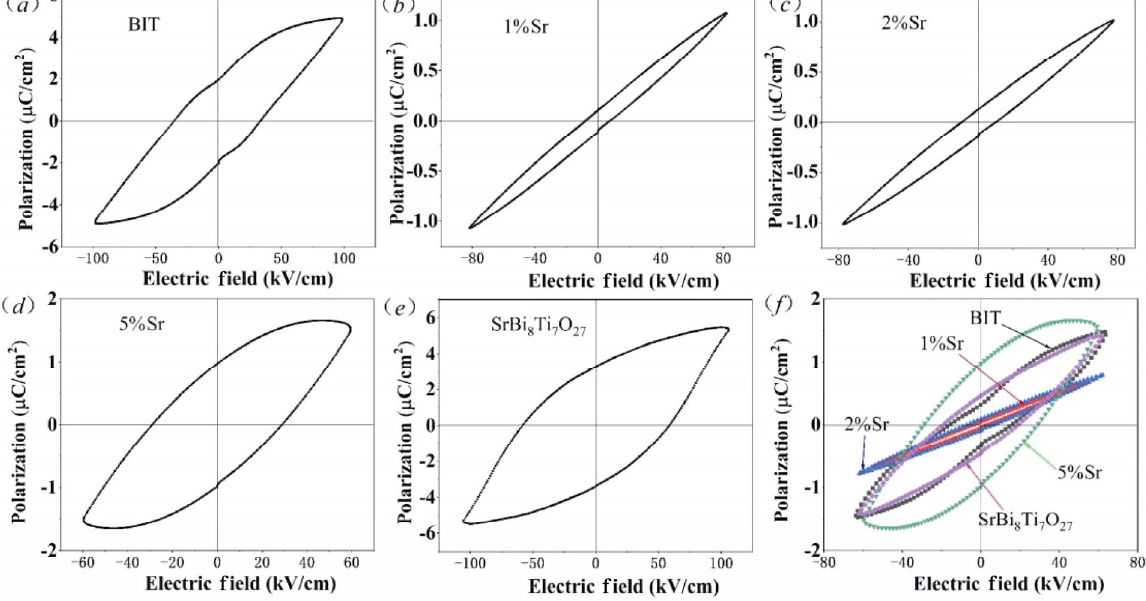
Fig. 8 P – E loop of Sr-doped ceramics: (a) BIT, (b) 1%Sr, (c) 2%Sr, (d) 5%Sr, (e) SrBi 8 Ti 7 O 27 ; (f) P – E loop of all the Sr-doped ceramics at 60